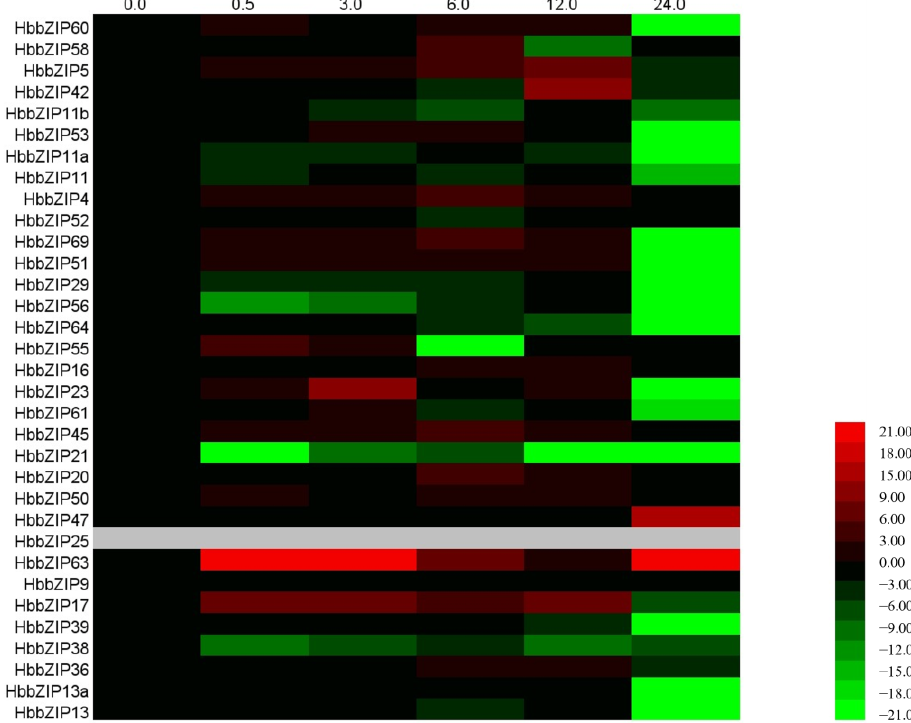
Figure 6. Expression of 33 HbbZIPs in rubber trees in response to powdery mildew infection.